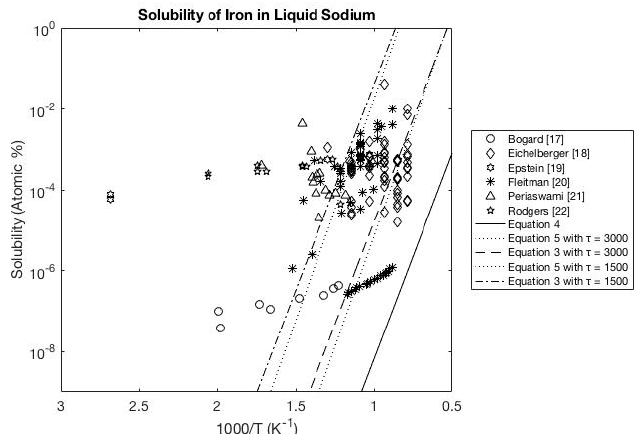
Figure 5. Solubility of iron in liquid sodium.